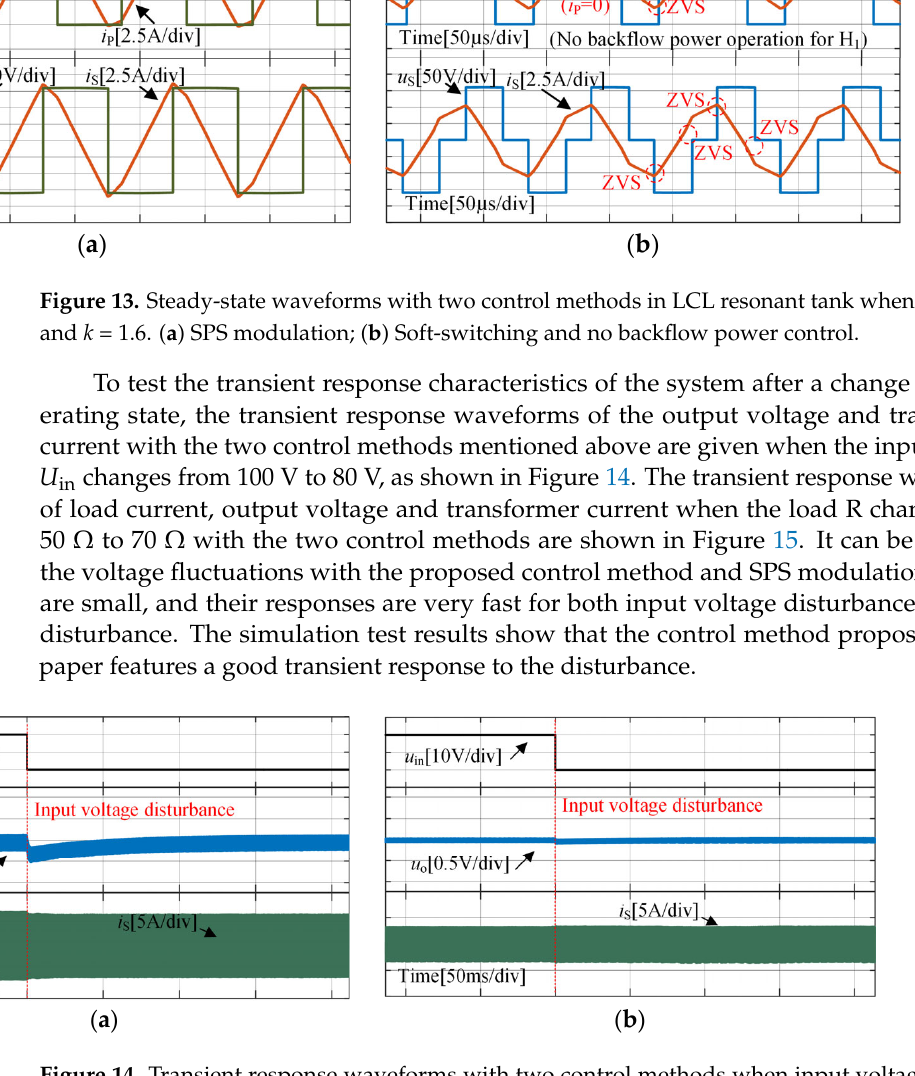
Figure 12. Steady ‐ state waveforms with two control methods in LCL resonant tank when U in = 50 V Figure 12. Steady-state waveforms with two control methods in LCL resonant tank when U in = 50 V and k = 1. ( a ) SPS modulation; ( b ) Soft ‐ switching and no backflow power control. and k = 1. ( a ) SPS modulation; ( b ) Soft-switching and no backflow power control.